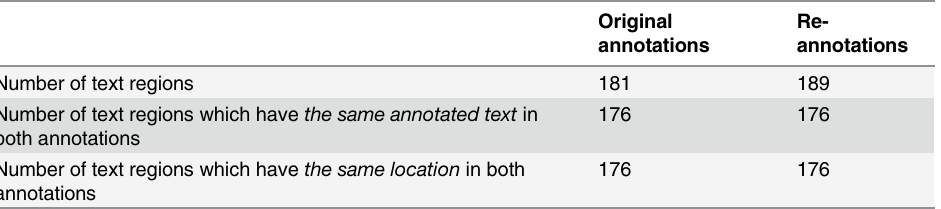
Table 1. The annotation agreement of the 10 figures randomly selected.